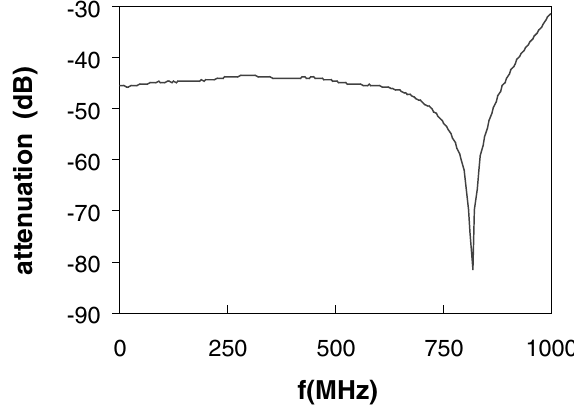
FIG. 14. Attenuation produced by the RP as a function of frequency (measured with theVNA). In the plateau, the average value is (cid:4) 45 dB and the maximum is (cid:4) 43 : 44 dB